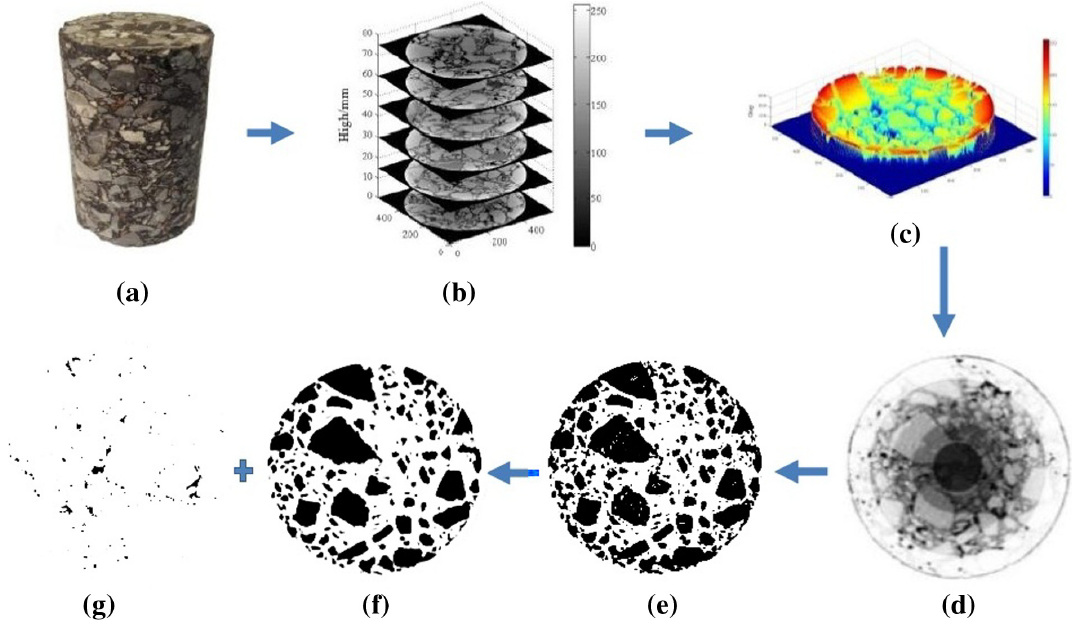
Figure 7. Extraction of the area of interest using CT scan technology [130]. ( a ) Asphalt concrete, ( b ) tomographic images, ( c ) gray distribution, ( d ) are of interest divided by annular masks, ( e ) initial binary image, ( f ) aggregate particles ( > 2.36 mm), ( g )